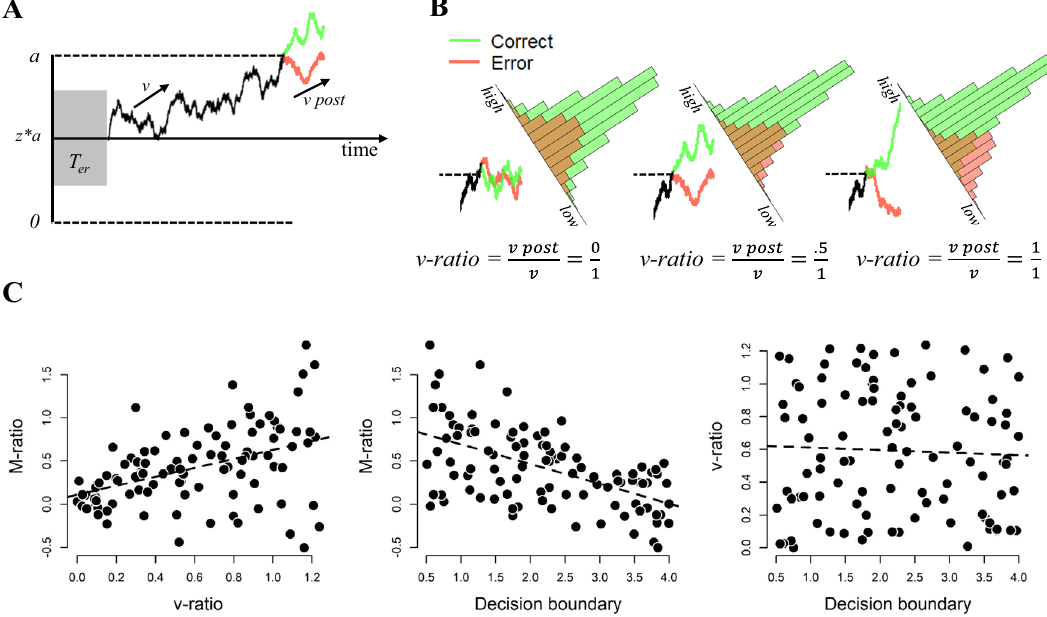
Fig. 1 Quantifying metacognitive accuracy within an evidence accumulation framework. A Noisy sensory evidence accumulates over time, until the integrated evidence reaches one of two decision boundaries (a or 0). After the decision boundary is reached, evidence continues to accumulate. Model con fi dence is quanti fi ed as the integrated evidence after post-decisional evidence accumulation. B Histograms of model-predicted con fi dence for different levels of v-ratio (re fl ecting the ratio between post-decision drift rate and drift rate). Higher levels of v-ratio are associated with better dissociating corrects from errors. C Simulations from this dynamic evidence accumulation model show that v-ratio captures variation in M-ratio ( r = 0.436; left panel), and critically, that M-ratio is also related to the differences in decision boundary ( r = − 0.552; middle panel). By design, decision boundary and v-ratio are unrelated to each other ( r ∼ 0; right panel). Data are based on N = 100 simulations. Source data are provided as a Source Data fi le.